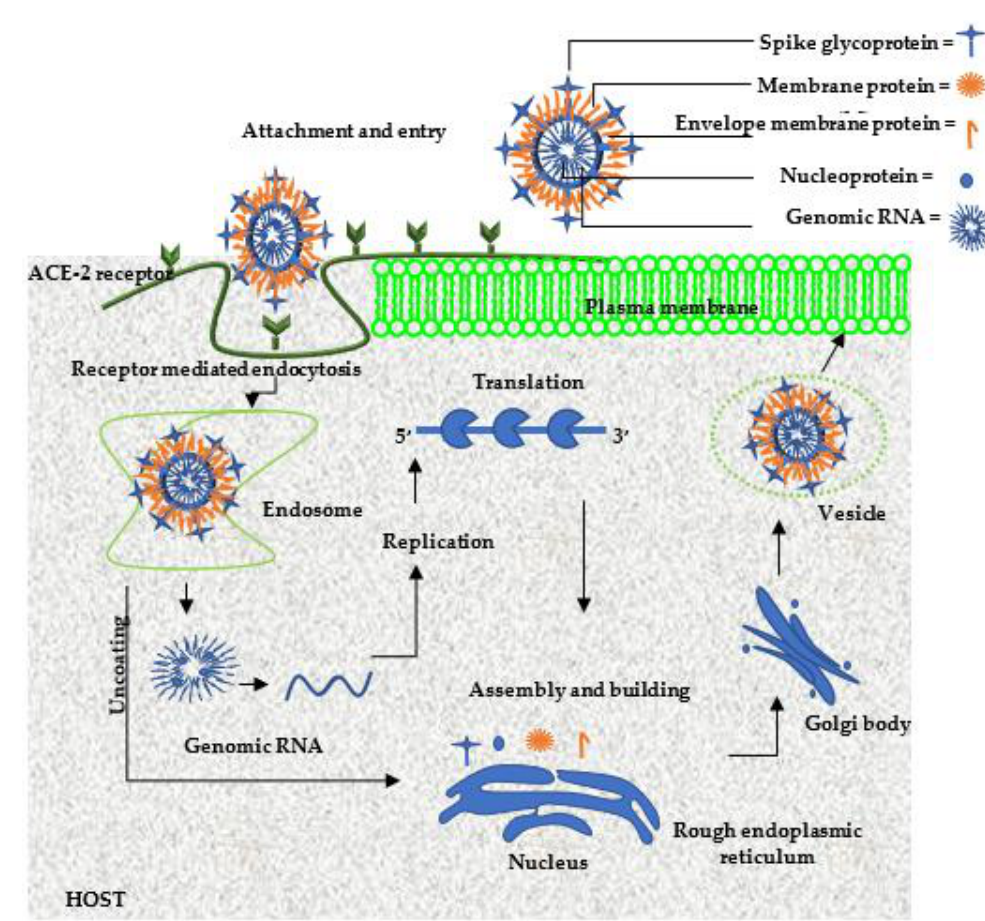
Figure 3. The life cycle of COVID-19/SARS-CoV-2.